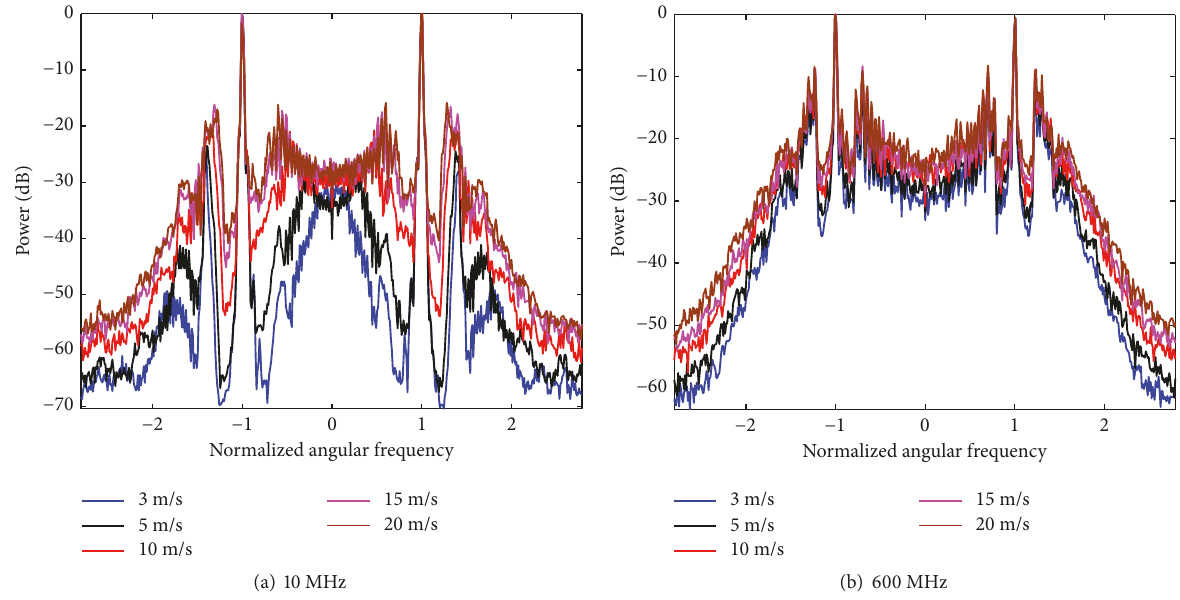
Figure 12: Doppler spectrum of Creamer waves in different sea states and different operating frequencies. The Doppler frequency is normalized by the Bragg frequency 𝜔 𝑏